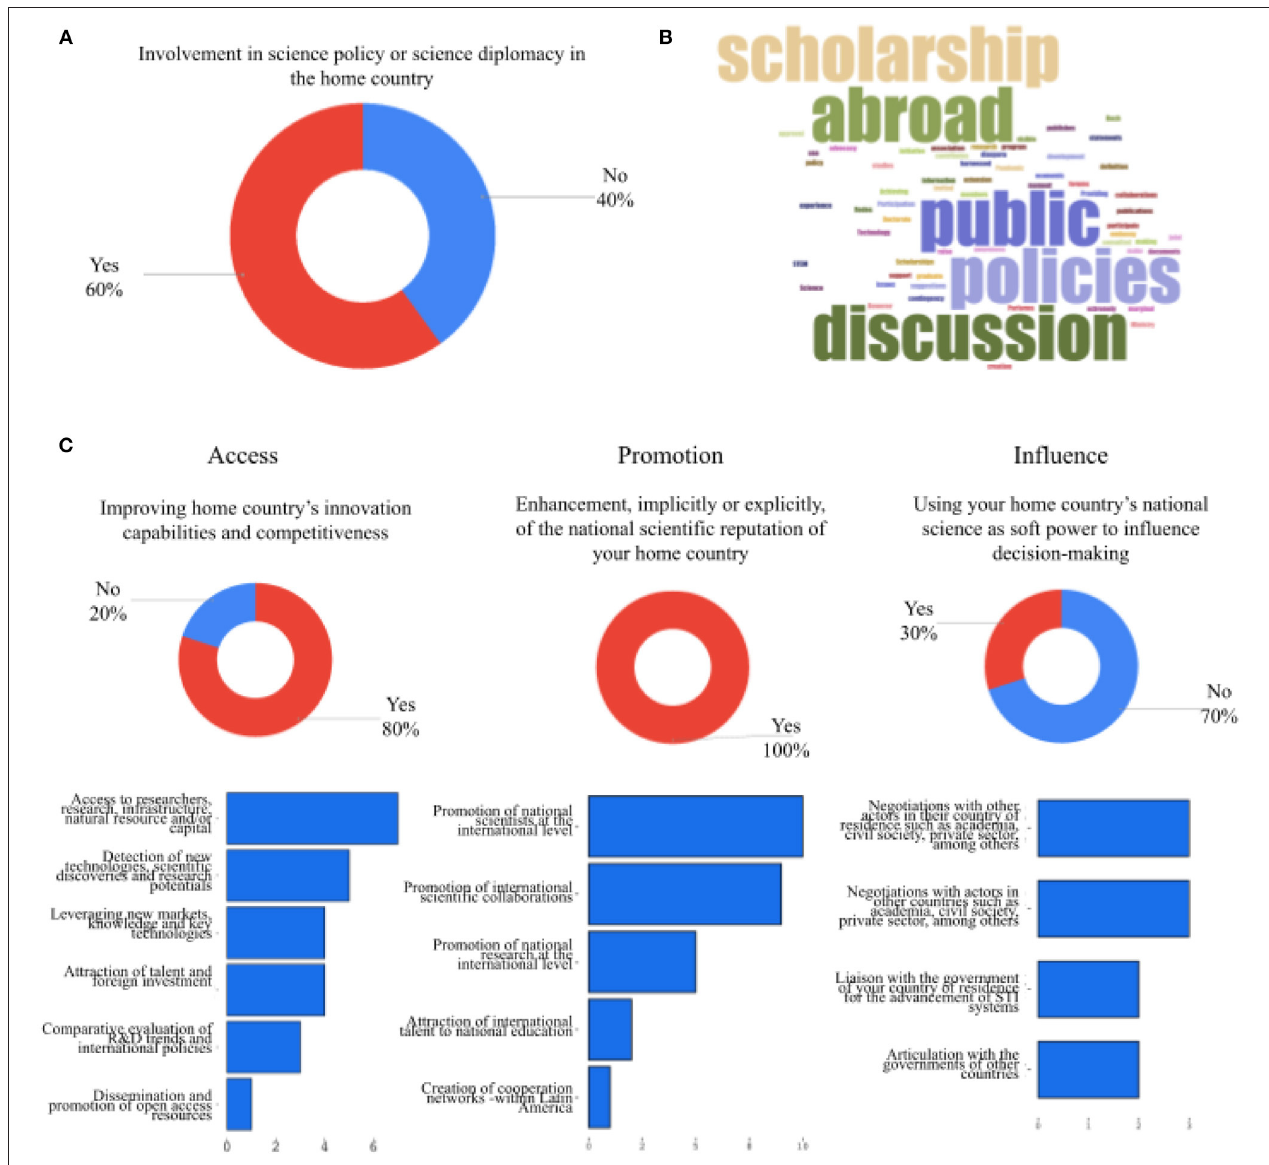
FIGURE 2 | Science diplomacy engagement of the diaspora networks. (A) Proportion of diaspora networks that self-employed engaging in science diplomacy activities. (B) Word cloud of answers to the question of how these diaspora networks engage in science diplomacy. Generated at https://www.jasondavies.com/ from translated answers. (C) Science diplomacy activities undertaken by the diaspora networks based on the definition of science diplomacy by Flink and Schreiterer (2010). Created by